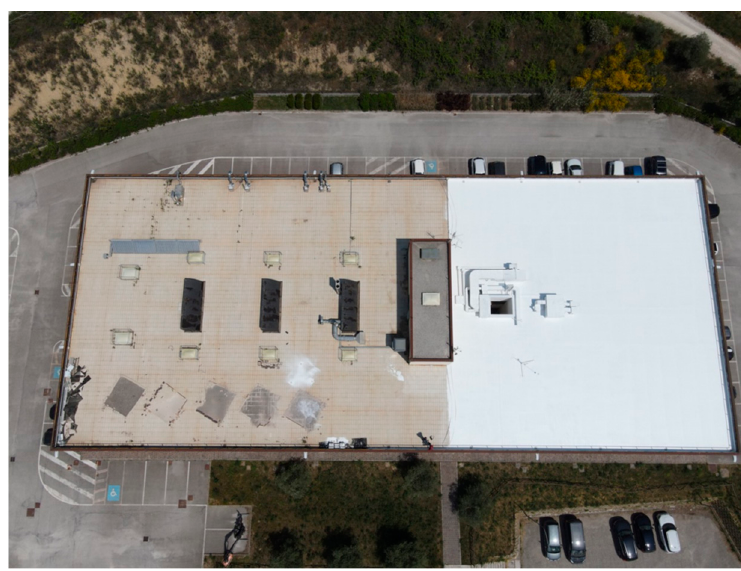
Figure 4. An aerial view of the SUT .